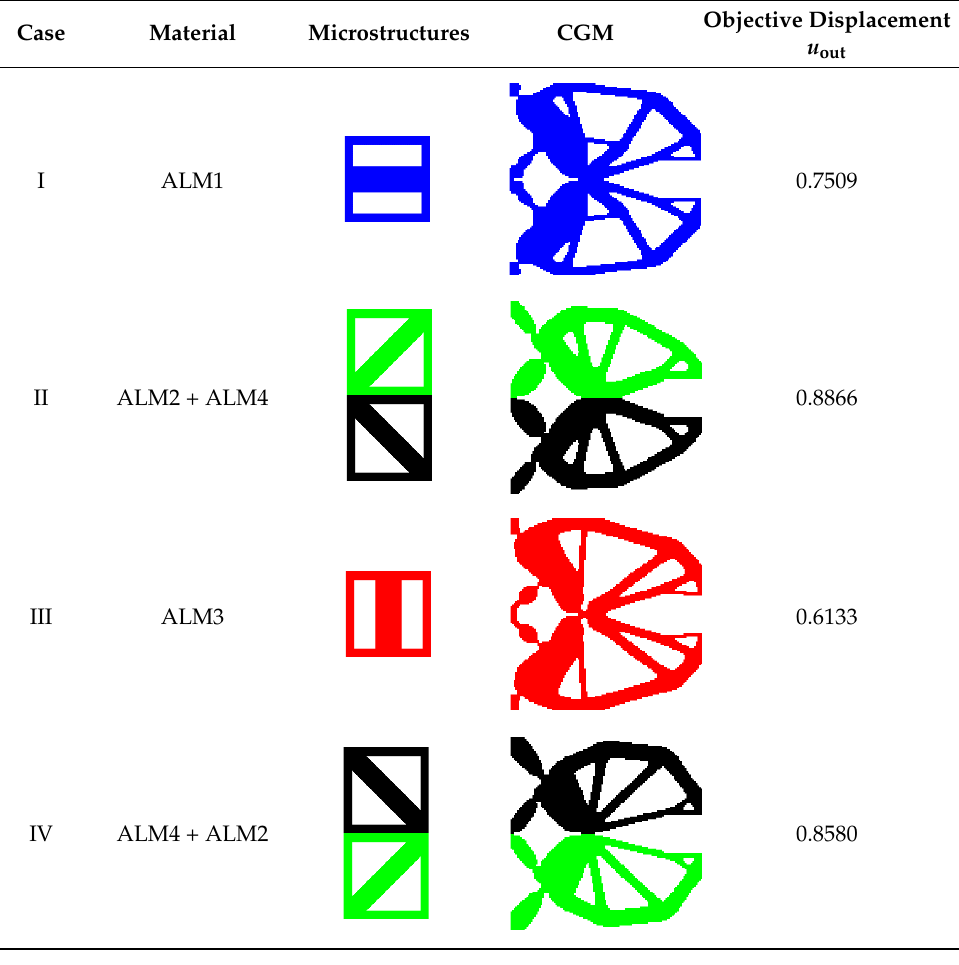
Table 5. CGMs with different lattice microstructures.